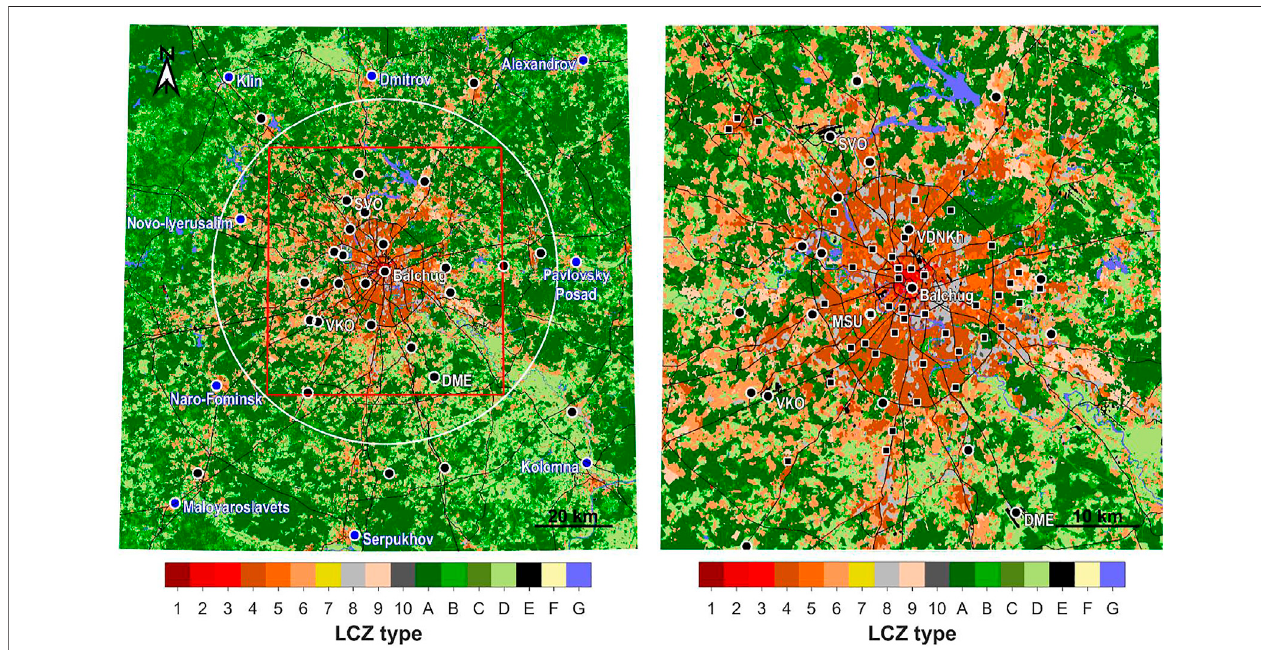
FIGURE1| LocalclimatezonemapfromVarentsovetal.(2020b)andreferencestations.Thewhitecircleintheleftsubplotdepictsthestudyareainvolvedinfurther statisticalanalysis,andtheredboxshowsthesmallerareashownindetailintherightsubplotandusedinthefollowingmaps.Circlemarkersindicatelocationofreference weather stations (WSs), and square markers indicate location of reference automatic air-quality stations (AAQSs, more info below). Nine WSs used to de fi ne mean background temperature are highlighted by blue.